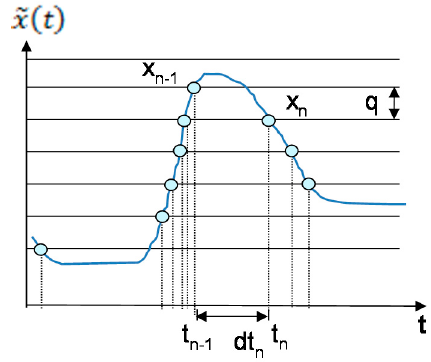
Figure 2. The principle of a level-crossing ADC with hysteresis.